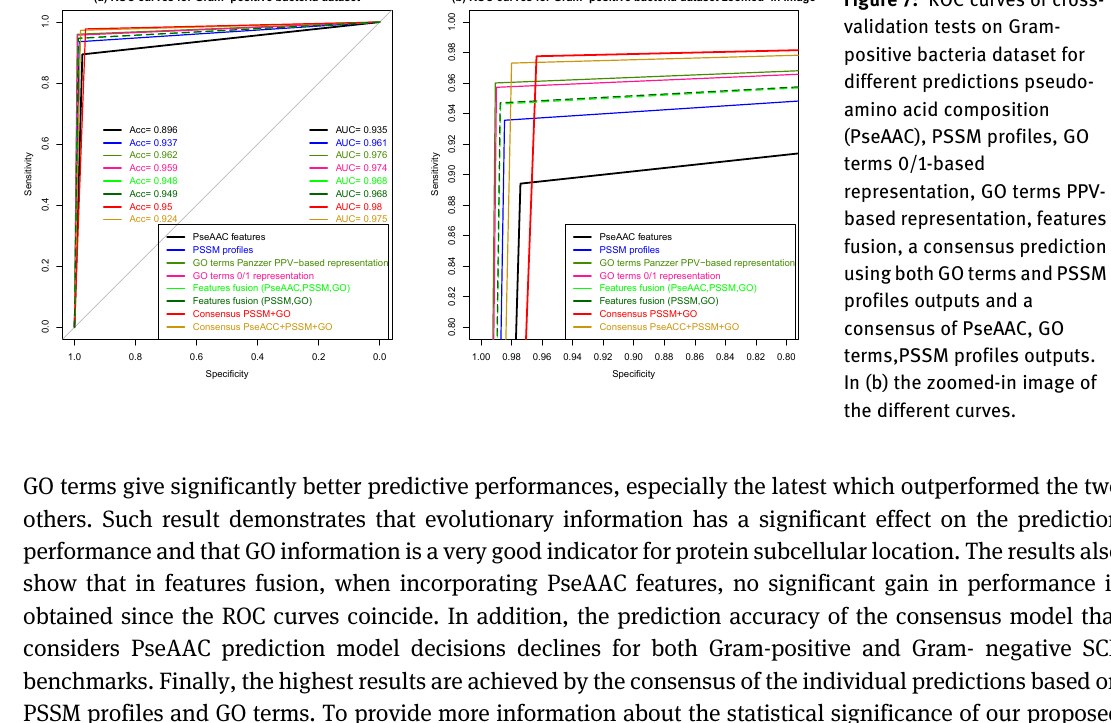
(b) ROC curves for Gram − positive bacteria dataset zoomed − in image Features fusion (PseAAC,PSSM,GO) Features fusion (PSSM,GO) Consensus PSSM+GO Consensus PseACC+PSSM+GO